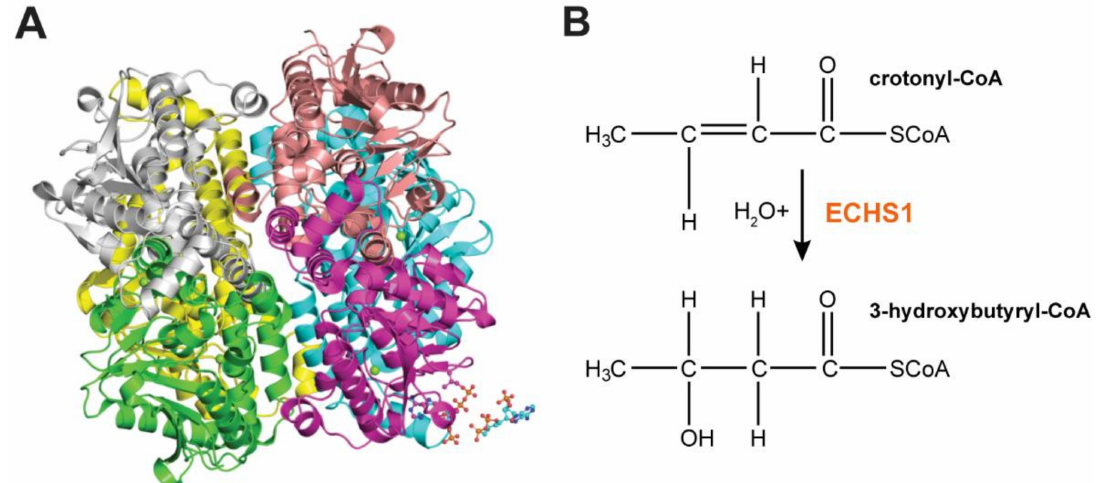
Figure 2. ECHS1 Structure and Function. ( A ) Homohexameric ECHS1 crystal structure at 2.55 Å resolution (PDB: 2hw5), showing six ECHS1 units colored by chain. Two copies of the 4-carbon substrate crotonyl-CoA are shown (bottom right hand corner). ( B ) ECHS1 catalyzes the conversion of trans- ∆ 2 -enoyl-CoA thioesters to 3- L -hydroxyacyl-CoA thioesters by stereospecific hydration of the trans double bond between carbons two and three. Hydration of crotonyl-CoA to 3-hydroxybutyryl- CoA is